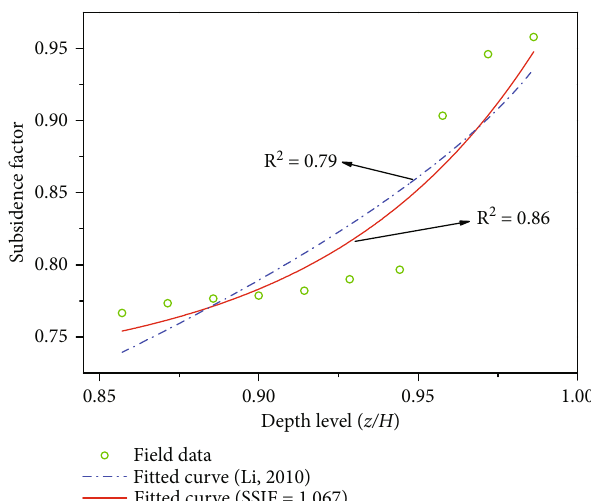
Field data Fitted curve (Li, 2010) Fitted curve (SSIF = 1.067) Figure 9: Curves of the subsurface subsidence factor fi tted by di ff erent methods in Sihe No. 2 the corresponding fi tted values for Li ’ s method are 0 : 59808 ± 0 : 13429 and 0 : 158 ± 0 : 267 .